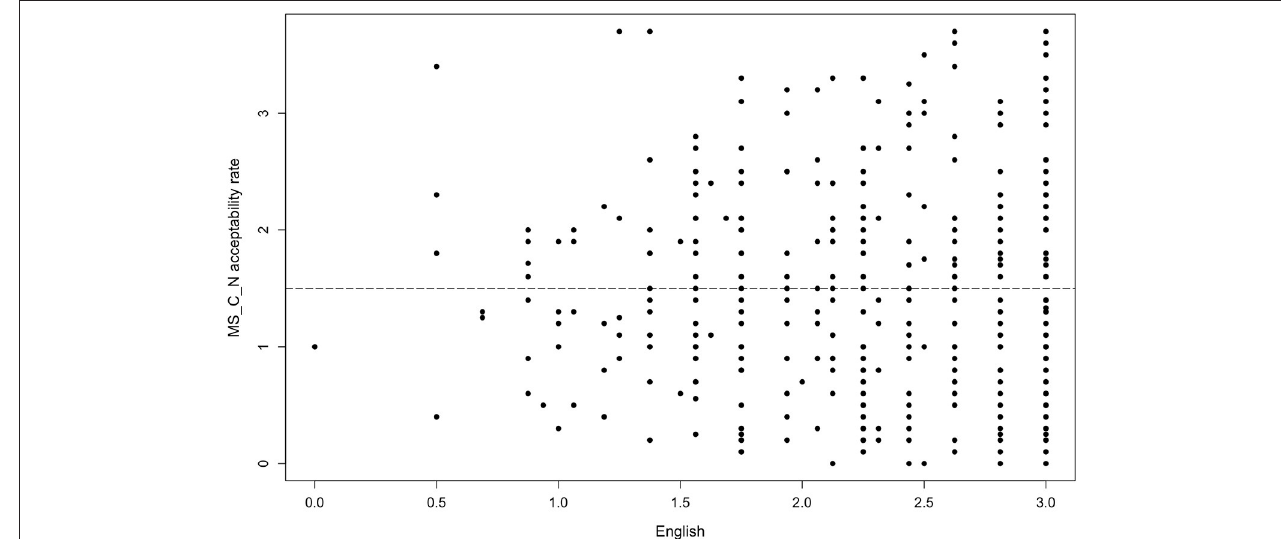
FIGURE 5 | Acceptability rate of deep -type in the non-agreement condition by proficiency in English.